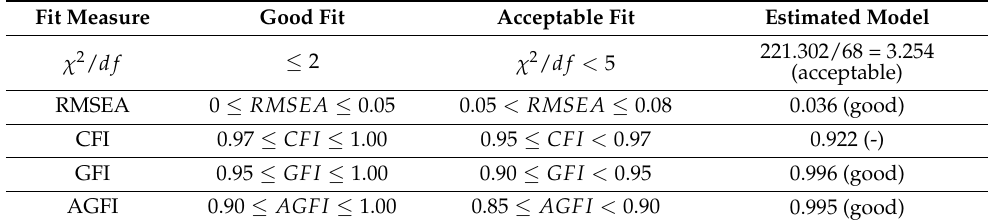
Table 5. Fit measures for model